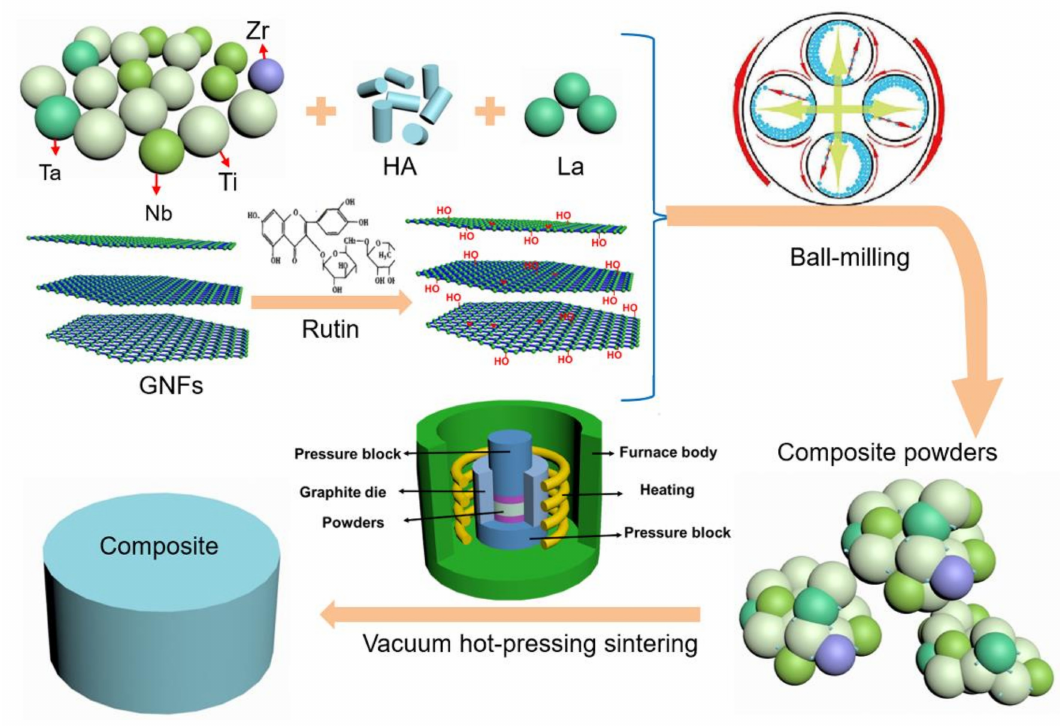
Figure 1. The schematic diagram of the